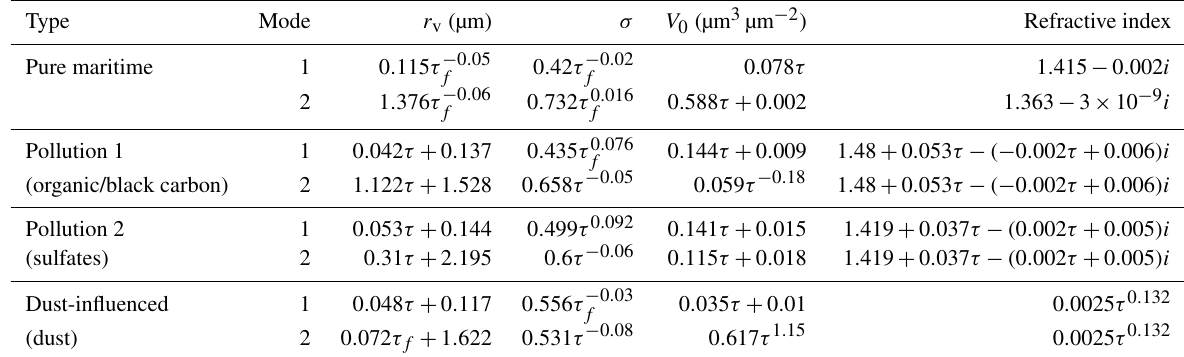
Table 4. Parameters of PSD function and refractive index of XBAER-ocean aerosol types according to Mei et al. (2018b).